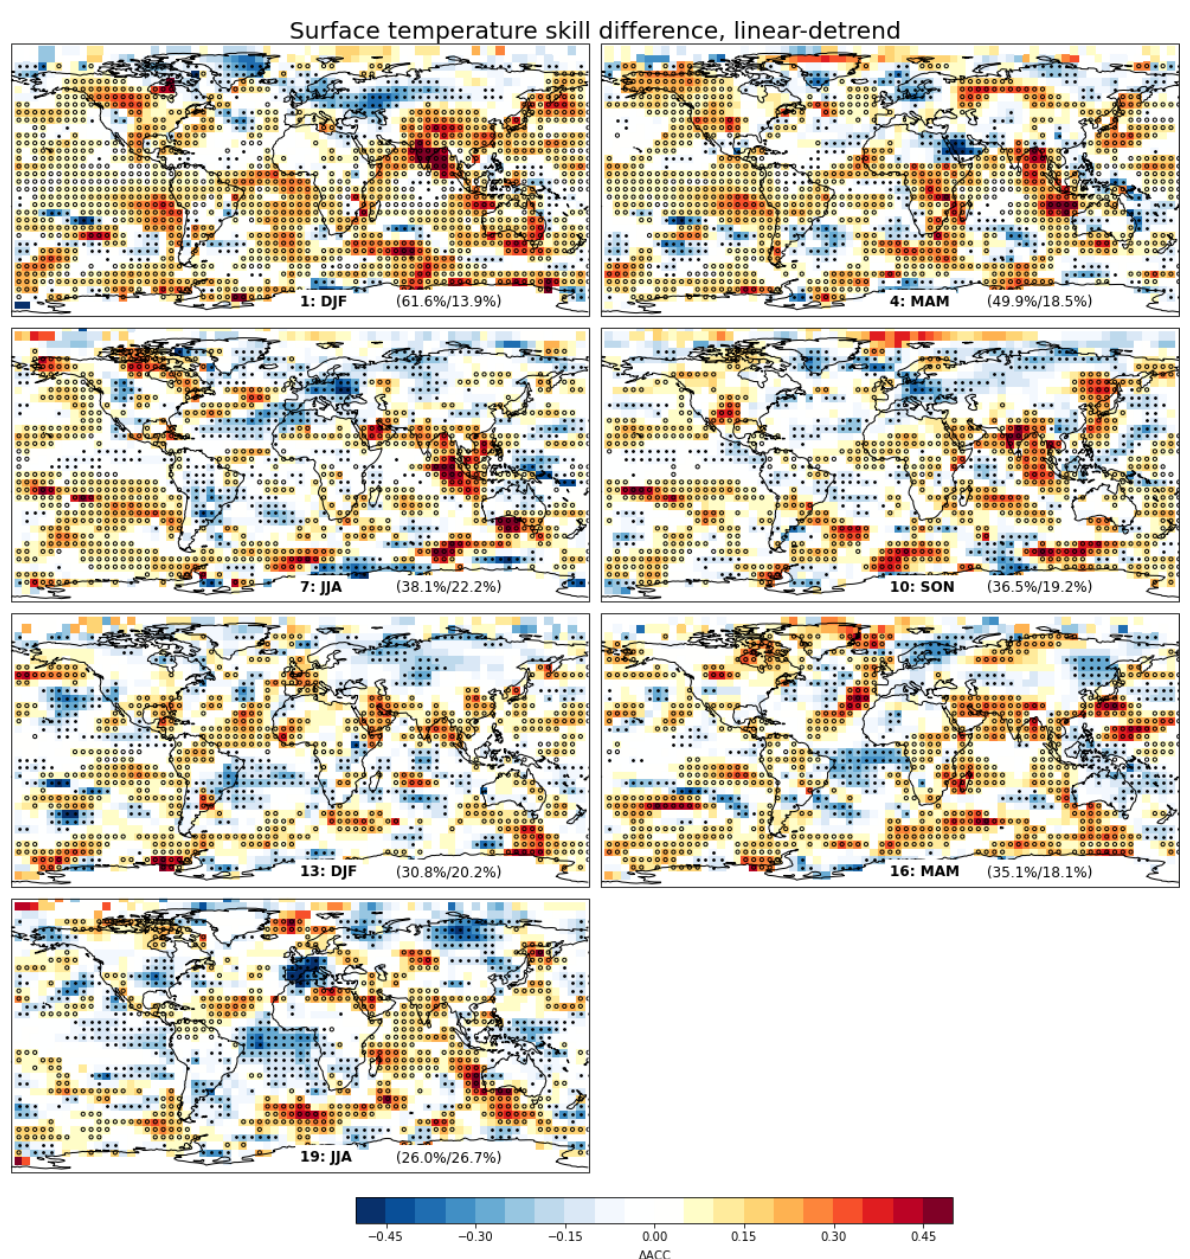
Figure B3. Difference in ACC skill for surface temperature between SMYLE-NOV and the mean of the 20-member skill score distribution from DPLE-NOV. Here, both hindcast sets use identical verification windows (corresponding to start dates spanning 1970–2017). Open and filled circles indicate significantly higher and lower ACC in SMYLE-NOV, respectively (corresponding to SMYLE-NOV skill falling above the 90th or below the 10th percentile of a 100-member distribution of 20-member DPLE-NOV scores). Values in parentheses give the percentage of global surface area (within 80 ◦ S–80 ◦ N) where there is significant skill increase/decrease.